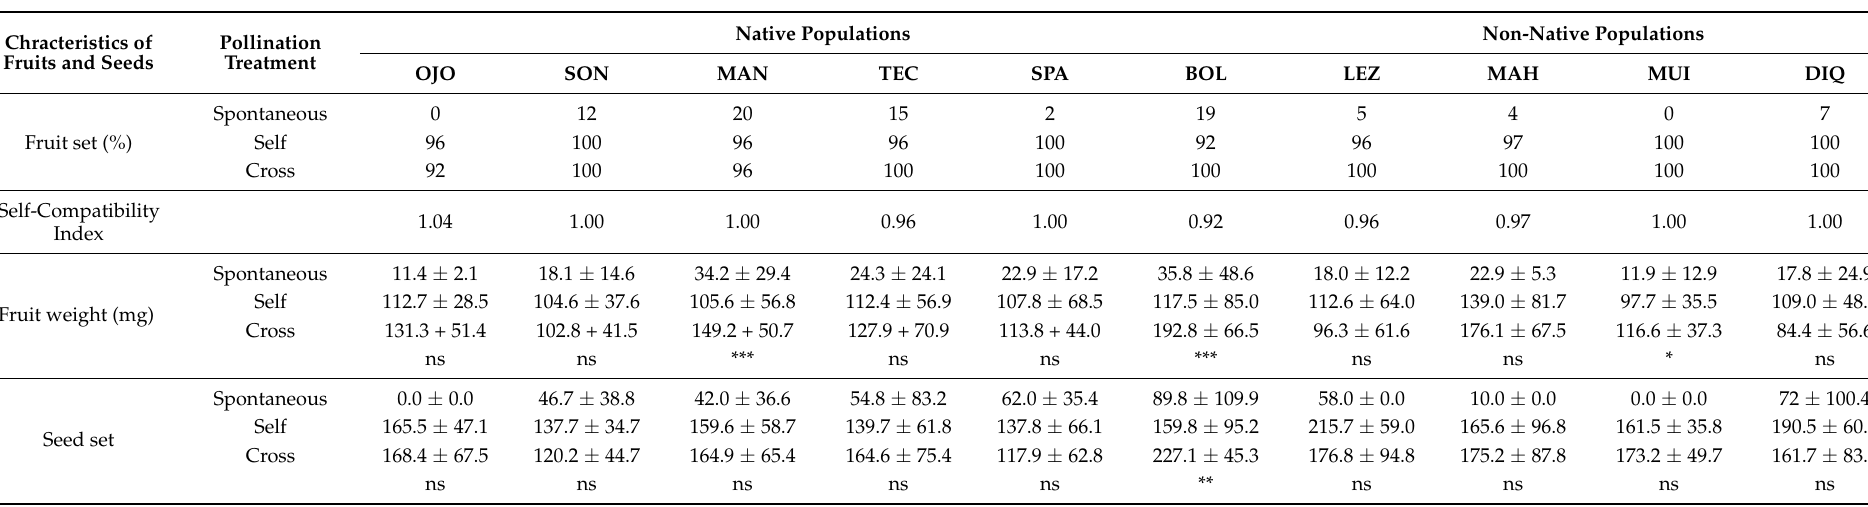
Table A2. Characteristics of the fruits and seeds (mean ± SD) obtained by spontaneous, self- and cross-pollination (Self and Cross, respectively) in flowers of native and non-native populations of Oenothera drummondii . The last row of each trait of fruits and seeds show the comparison (Wilcoxon test) between self- and cross-pollination data of each population (ns = not significant; * p = 0.05; ** p = 0.01; *** p = <0.001). Population acronyms provided in Figure 1and Table